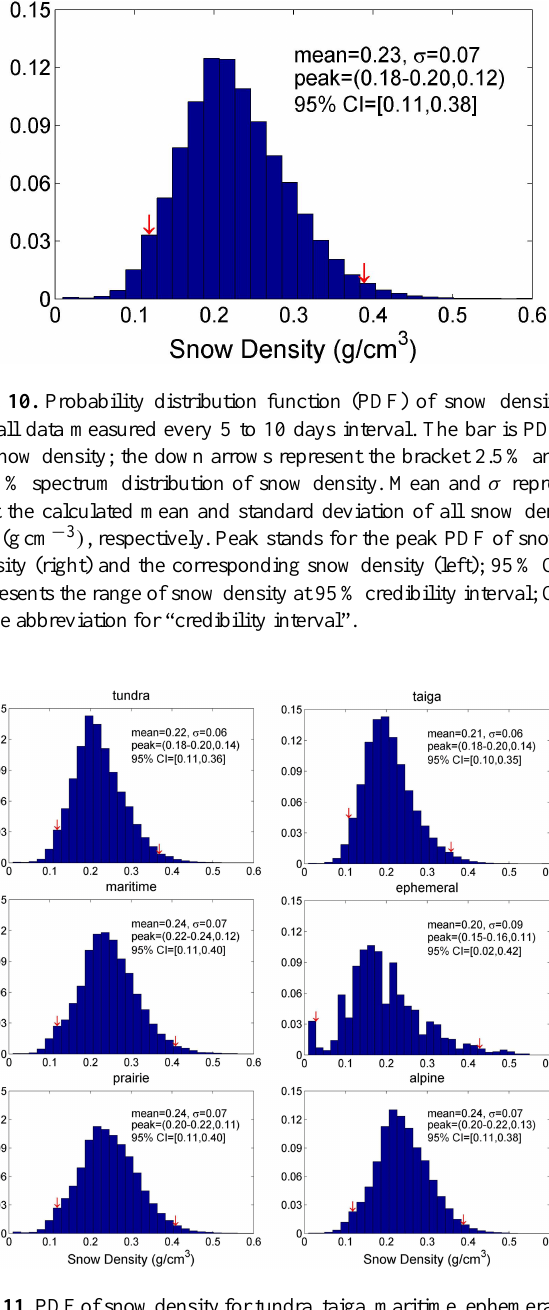
Fig. 11. PDF of snow density for tundra, taiga, maritime, ephemeral, prairie, and alpine snow. The bar is PDF of snow density; the down arrows represent the bracket 2.5% and 97.5% spectrum distribu- tion of snow density. Mean and σ represent the calculated mean and standard deviation of all snow density (gcm − 3 ) , respectively. Peak stands for the peak PDF of snow density (right) and the corre- sponding snow density (left); 95% CI represents the range of snow density at 95% credibility interval; CI is the abbreviation for “cred- ibility interval”.